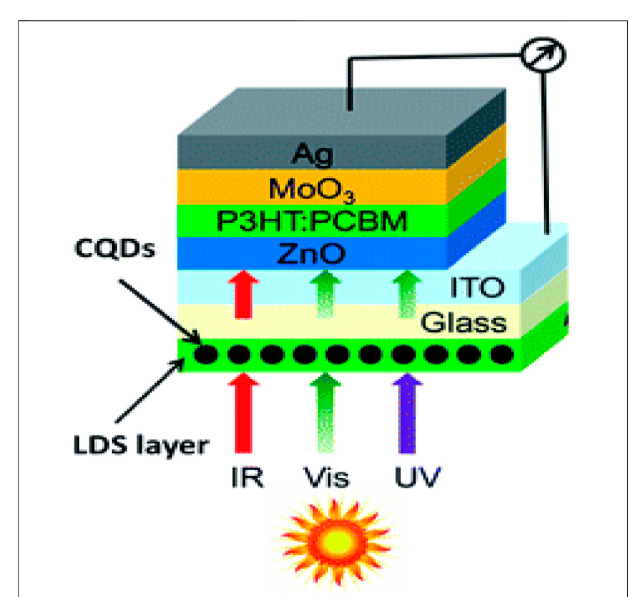
FIGURE 17 | Schematic architecture of the BHJ solar cell with the LDS layer. Reprinted with the permission from (Wang and Hu,